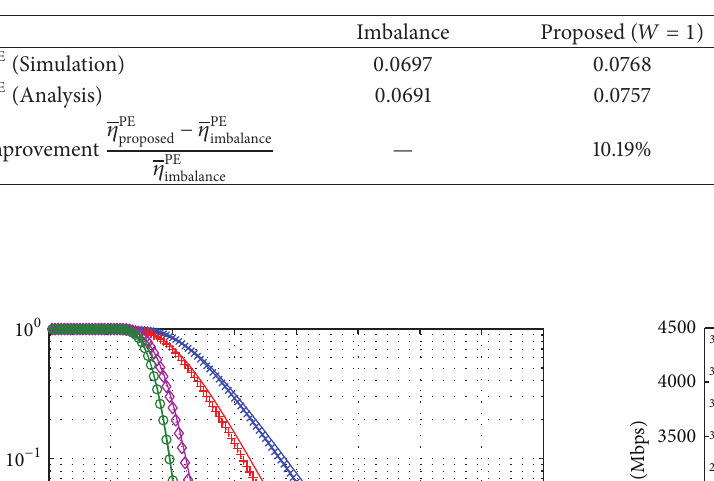
Table 3: A comparison of average power efficiencies.